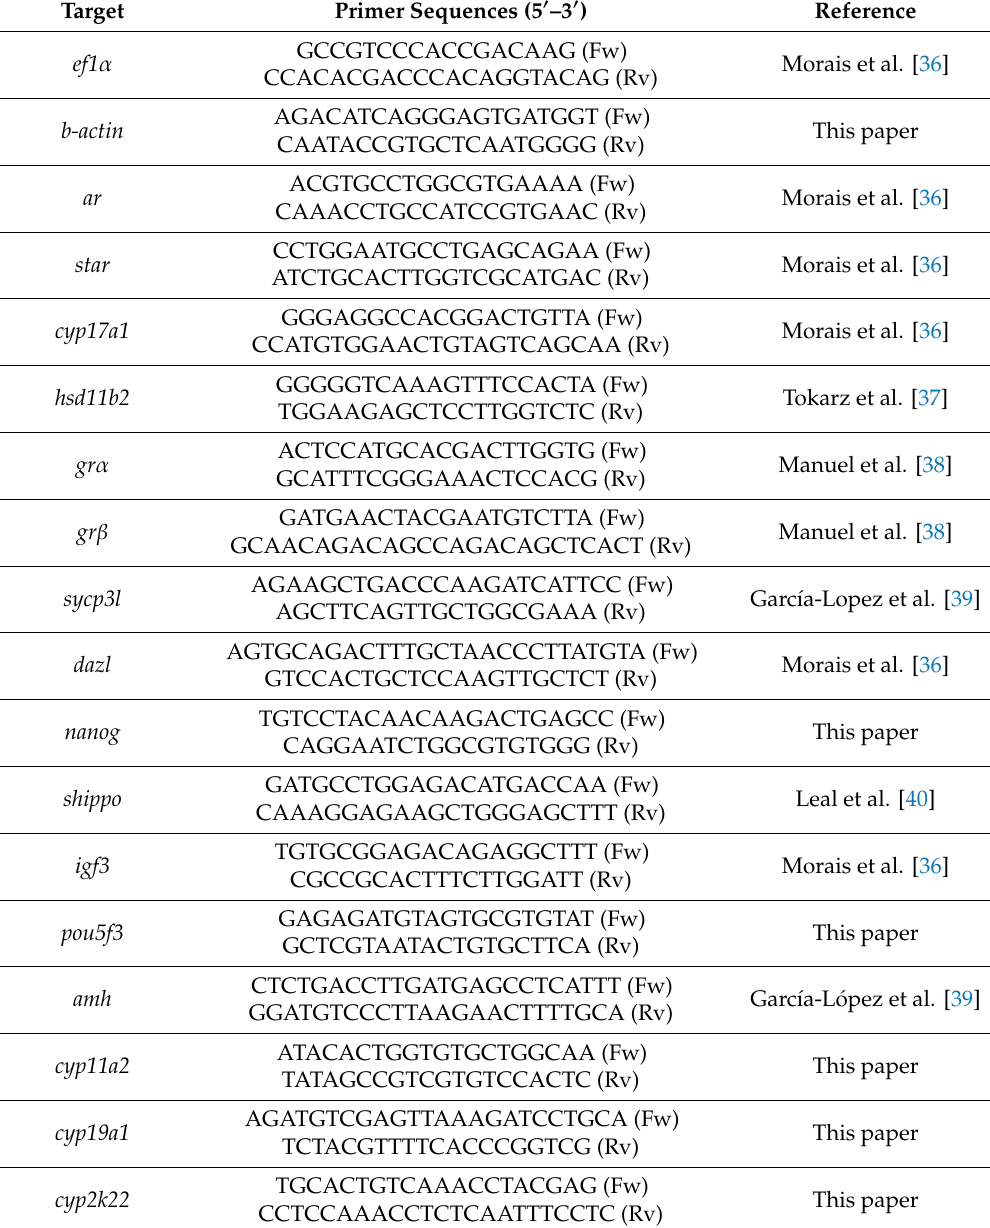
Table 1. Primers used for gene expression studies (qPCR) and to generate DNA templates for digoxigenin (DIG)-labeled cRNA probe syntheses for in situ hybridization